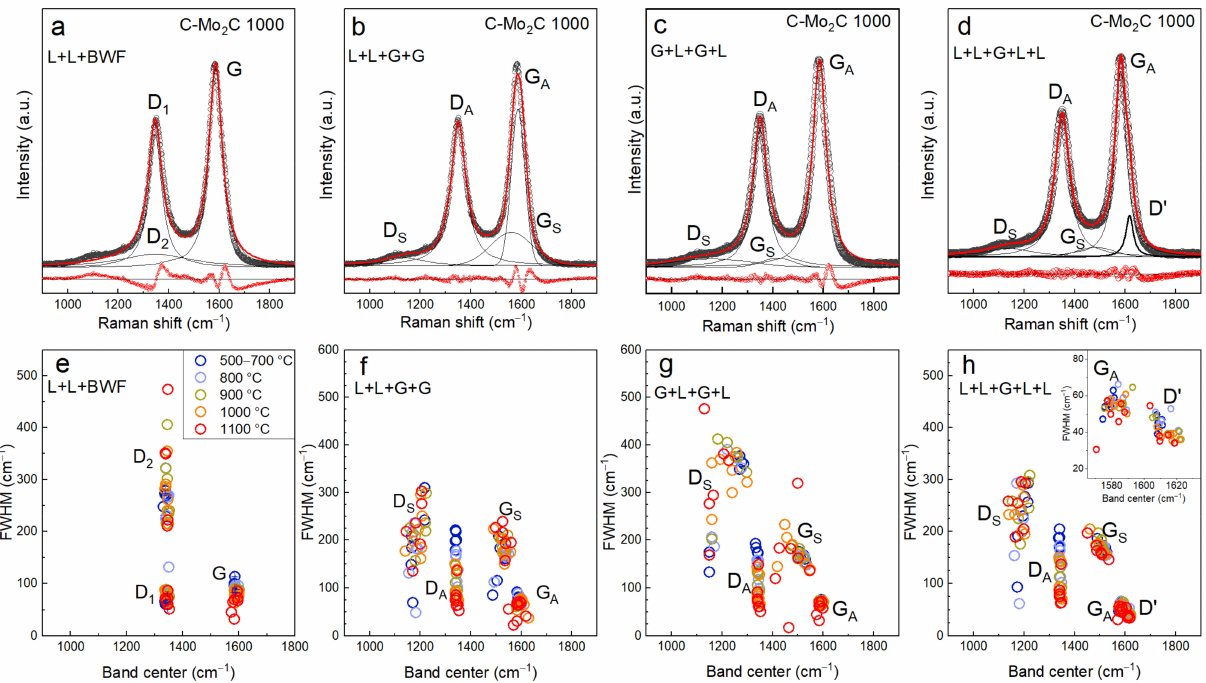
Figure 3. The deconvolution of the first-order Raman spectrum of C-Mo 2 C 1000 using ( a ) L + L + BWF, ( b ) L + L + G + G, ( c ) G + L + G + L and ( d ) L + L + G + L + L deconvolution methods. Experimental spectra are given as scatter plots (black circles), fits are given as solid lines (orange lines for cumulative fits and black lines for single peak fits). The residuals (red dots) are plotted below the spectra. Plots of the full width half maximum (FWHM) of the band vs. the band center position ( x 0 ) obtained by different first order Raman spectrum band deconvolution methods ( e ) L + L + BWF, ( f ) L + L + G + G, ( g ) G + L + G + L and ( h ) L + L + G + L + L deconvolution methods for CDCs synthesized at different temperatures (noted in Figure). The inset in ( h ) shows the zoomed in G-band